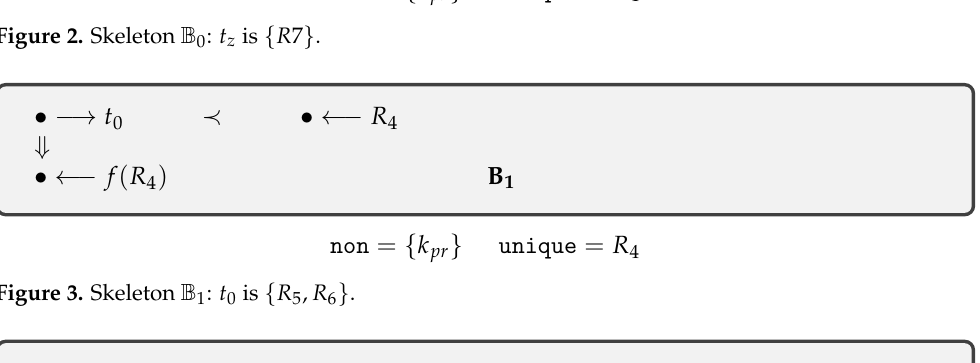
Figure 2. Skeleton B 0 : t z is { R 7 } .